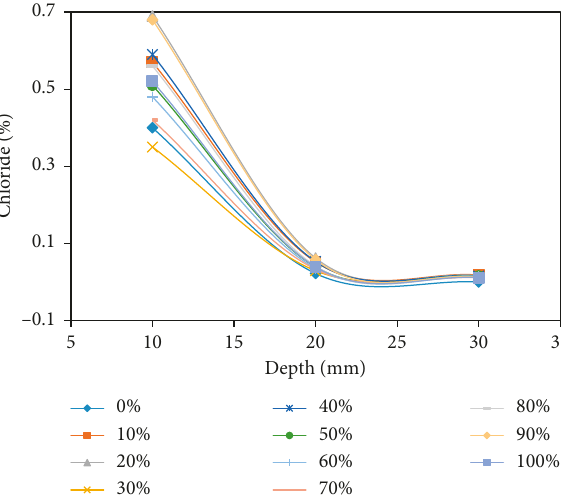
Figure 10: Chloride diffusion for all mixes after 2 weeks.